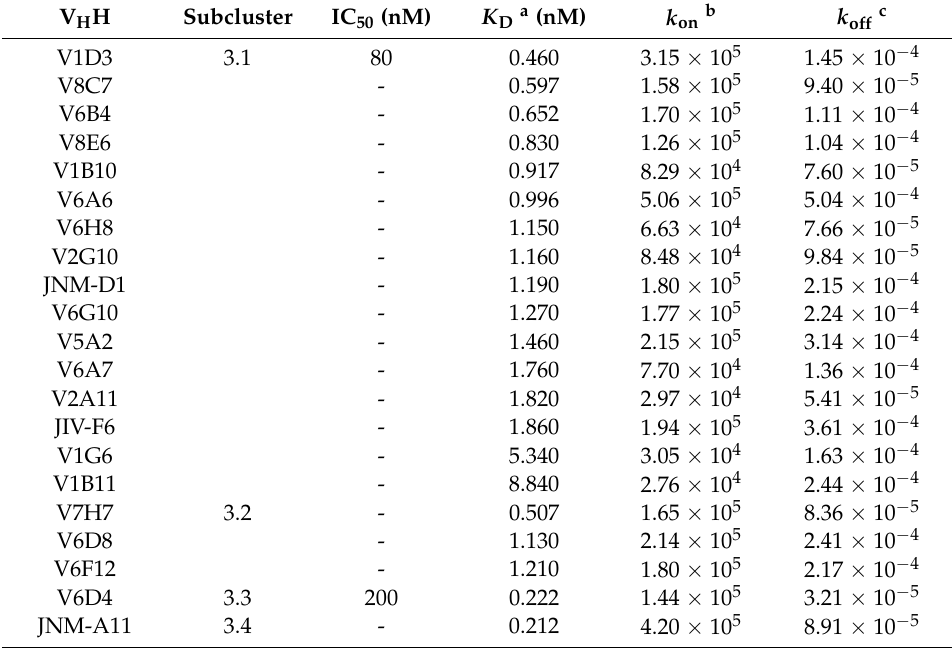
Table 2. Cluster 3 V H H TNA and Binding